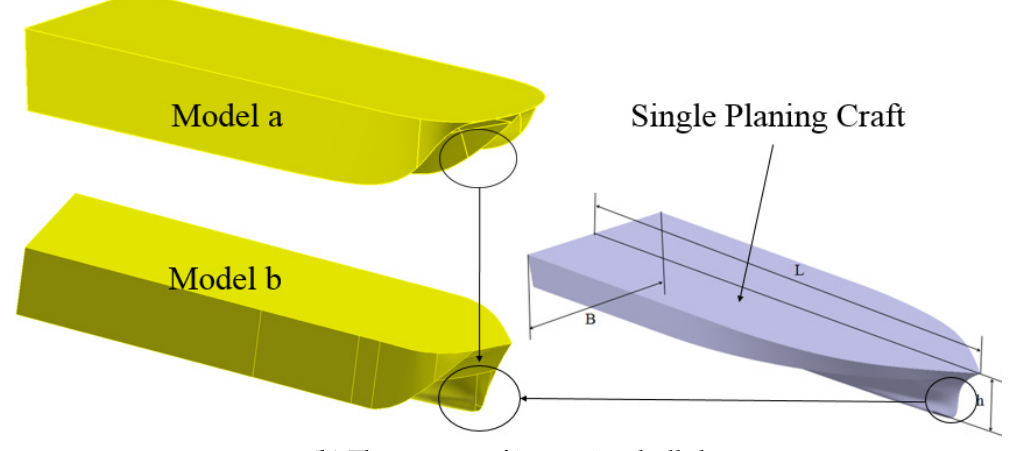
Table 6. The difference in hull parameters between Model a and Model b.